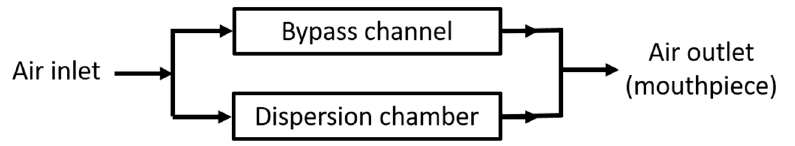
Figure 6. Schematic of a DPI device layout with a bypass channel to achieve flow